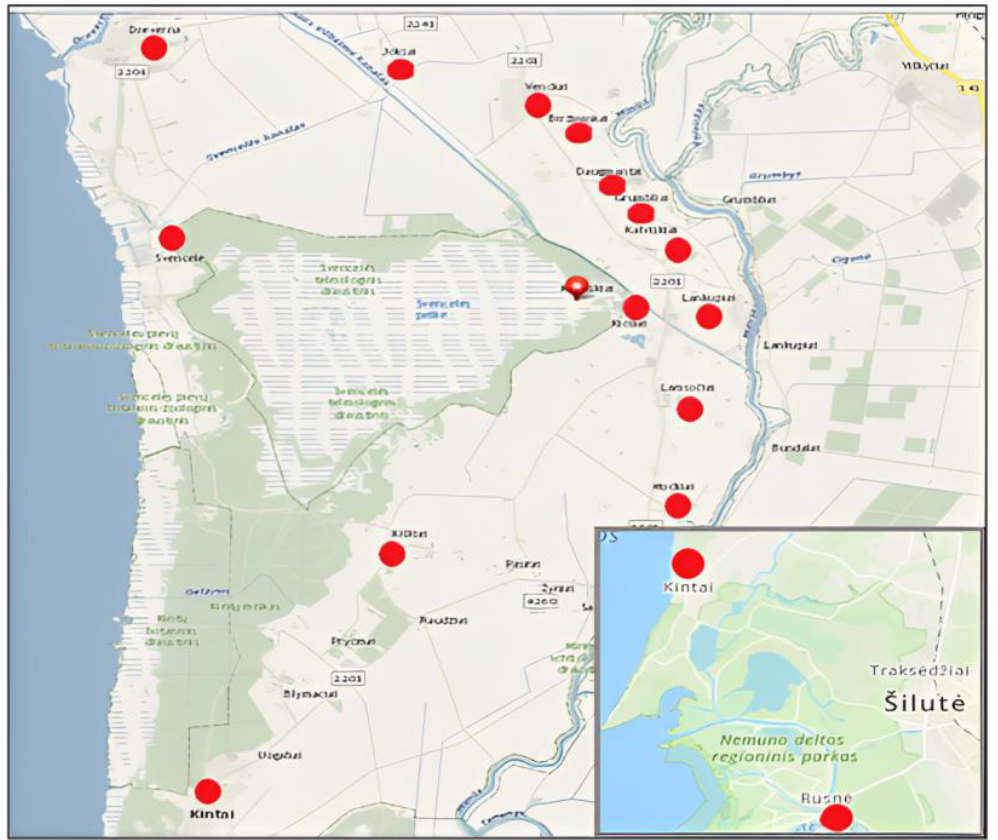
Figure 3. Map of Myrica gale survey area in Western Lithuania. Red circles indicate locations of inter-views taken from residents.